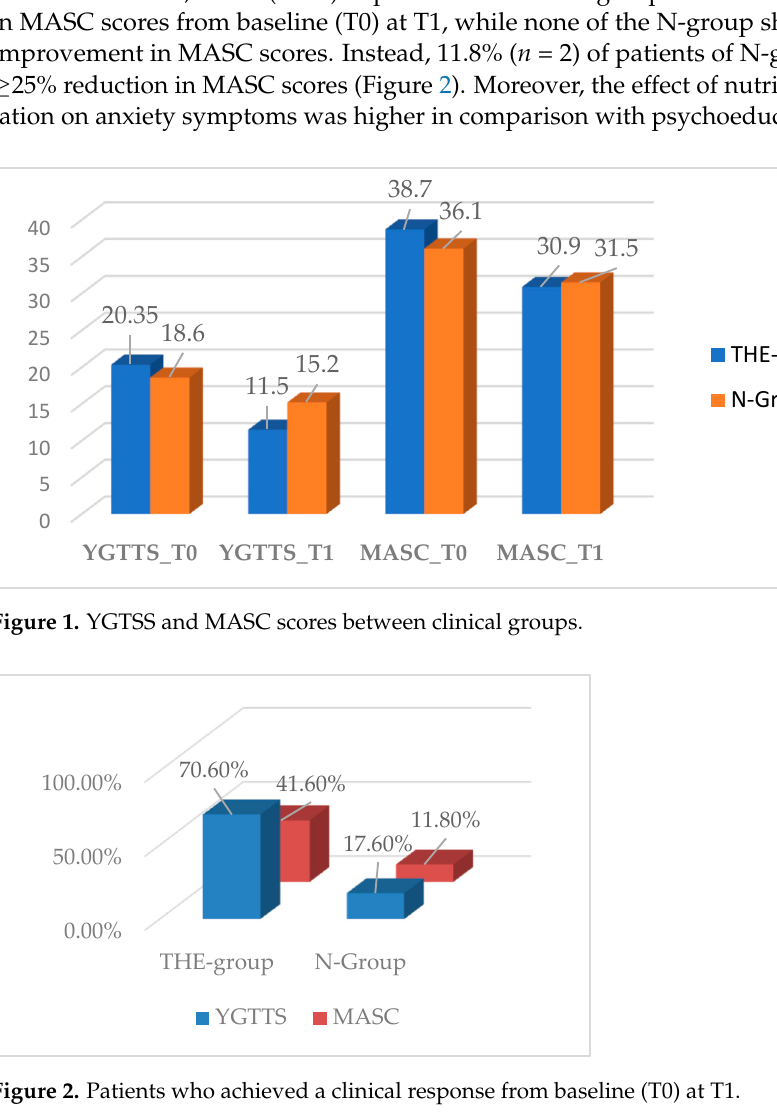
Figure 2. Patients who achieved a clinical response from baseline (T0) at T1.